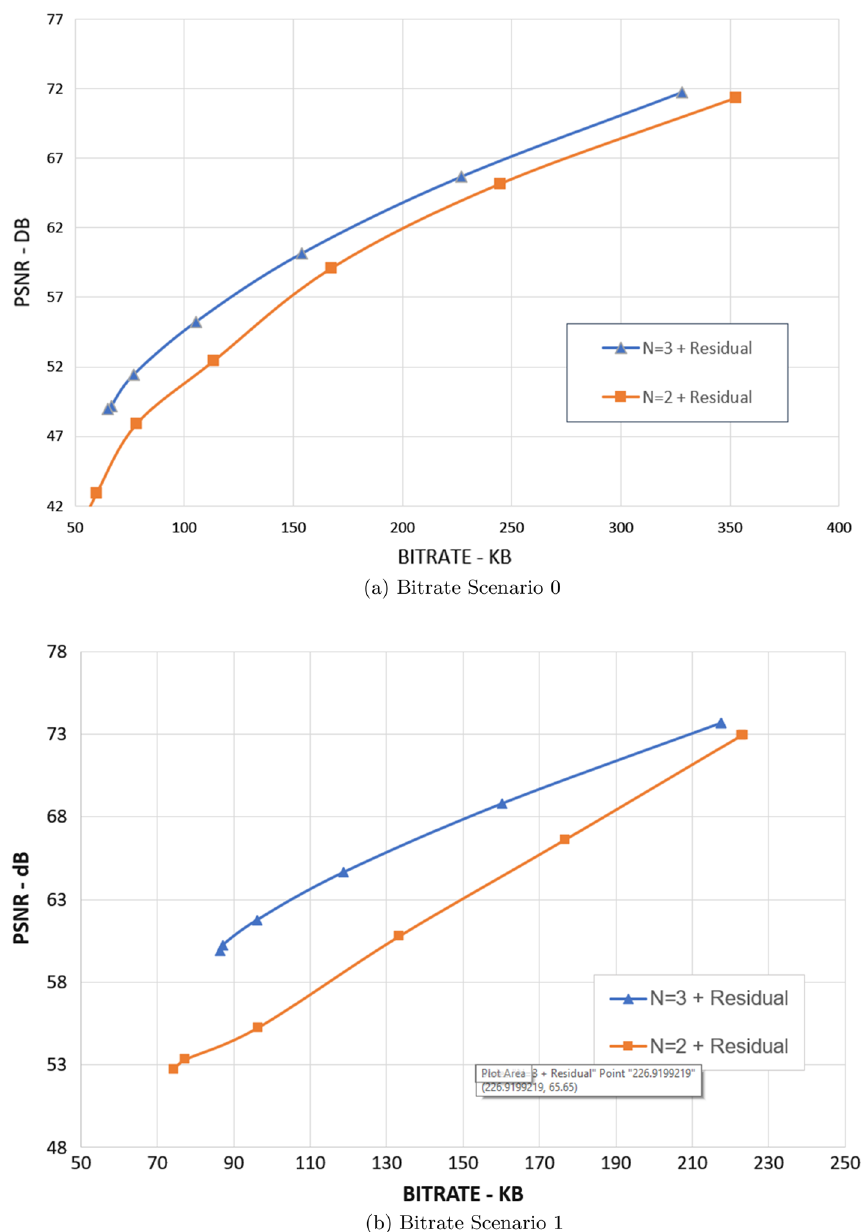
Fig. 5 Bitrate comparison with different fit